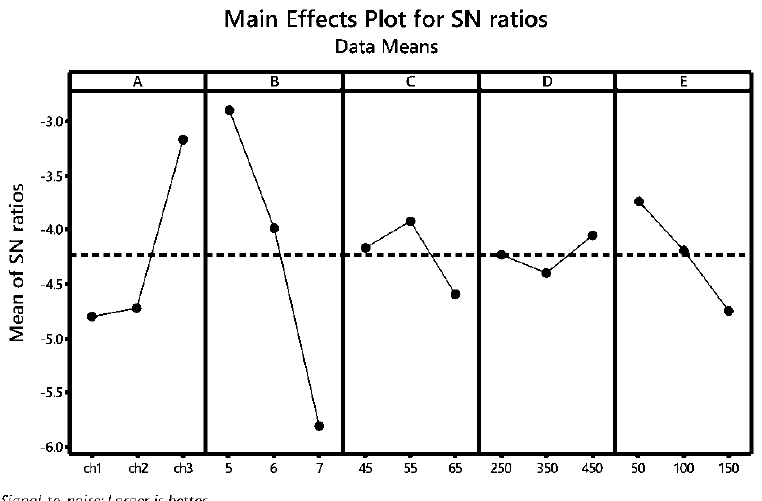
Figure 3. Main effects plot for the S/N analysis of the grey relational grade (GRG) during the flocculation of the Bacillus sp. BioSol021 cultivation broth and antimicrobial activity testing against the selected phytopathogens: A—chitosan type, B—pH value, C—chitosan dosage (mg/mL), D—rapid mixing speed (rpm), E—slow mixing speed (rpm)